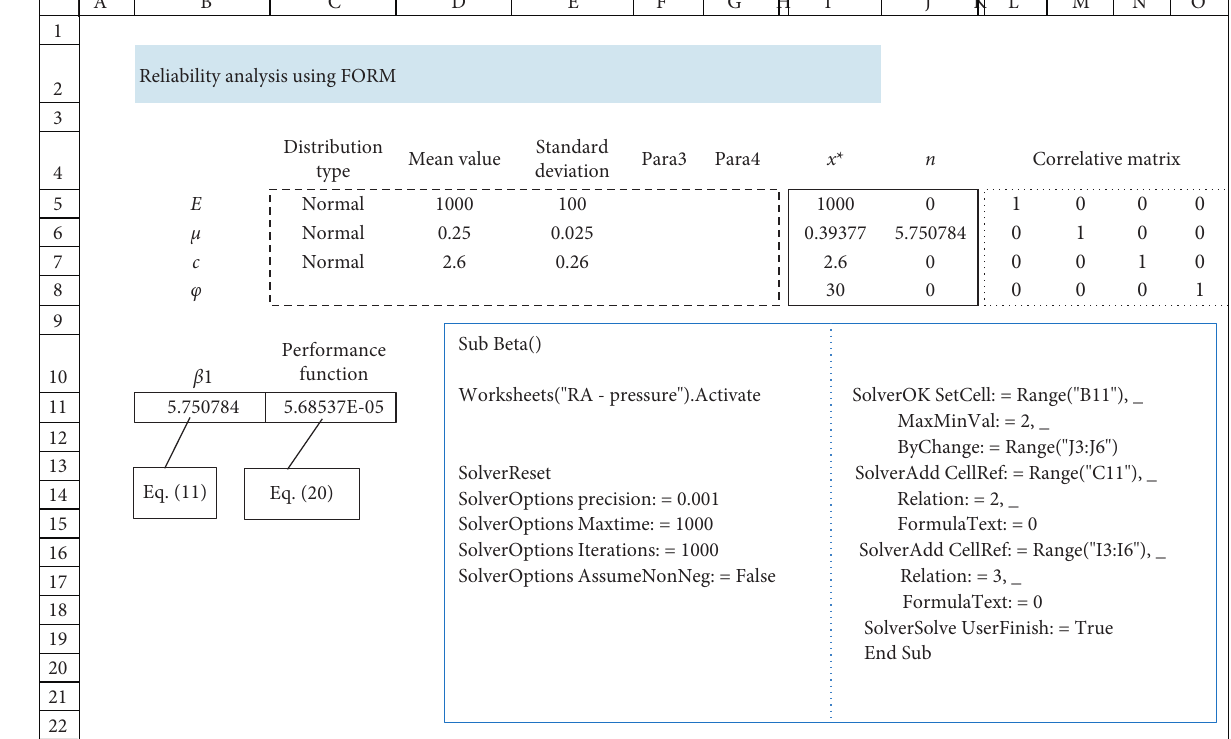
Figure 4: Worksheet of the reliability analysis and